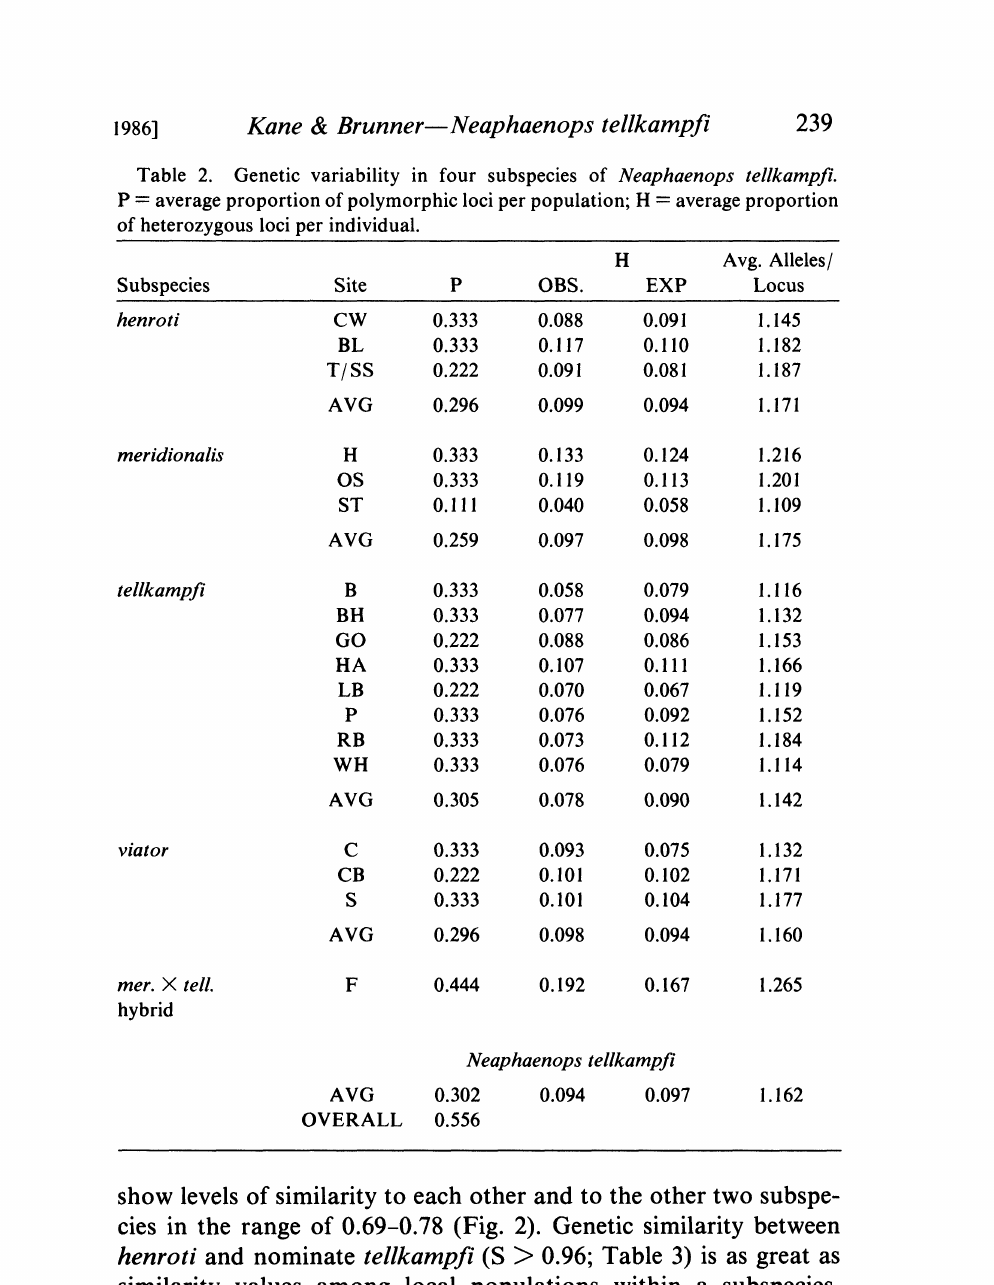
Table 2. Genetic variability in four subspecies of Neaphaenops tellkampfi. P average proportion of polymorphic loci per population; H average proportion of heterozygous loci per individual. H Avg. Alleles/ Subspecies Site P OBS. EXP